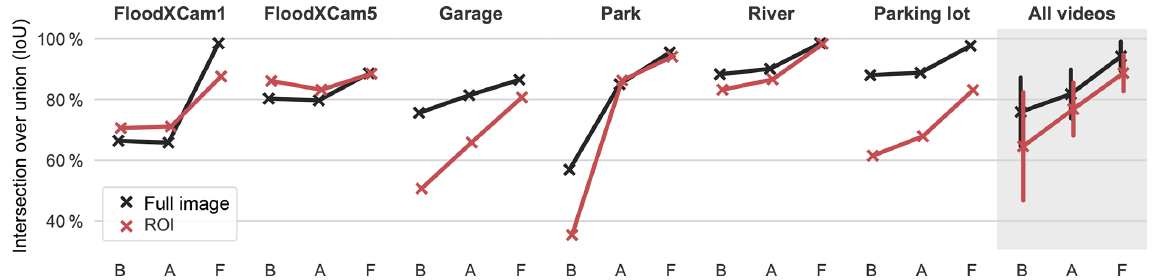
Figure 5. Automatic segmentation performance measured in terms of the intersection over union (IoU) for each video using the Basic (B), Augmented (A), and Fine-tuned (F) DCNNs. On the right side, the overall performance for all videos is depicted, with the vertical segments representing the standard deviation of